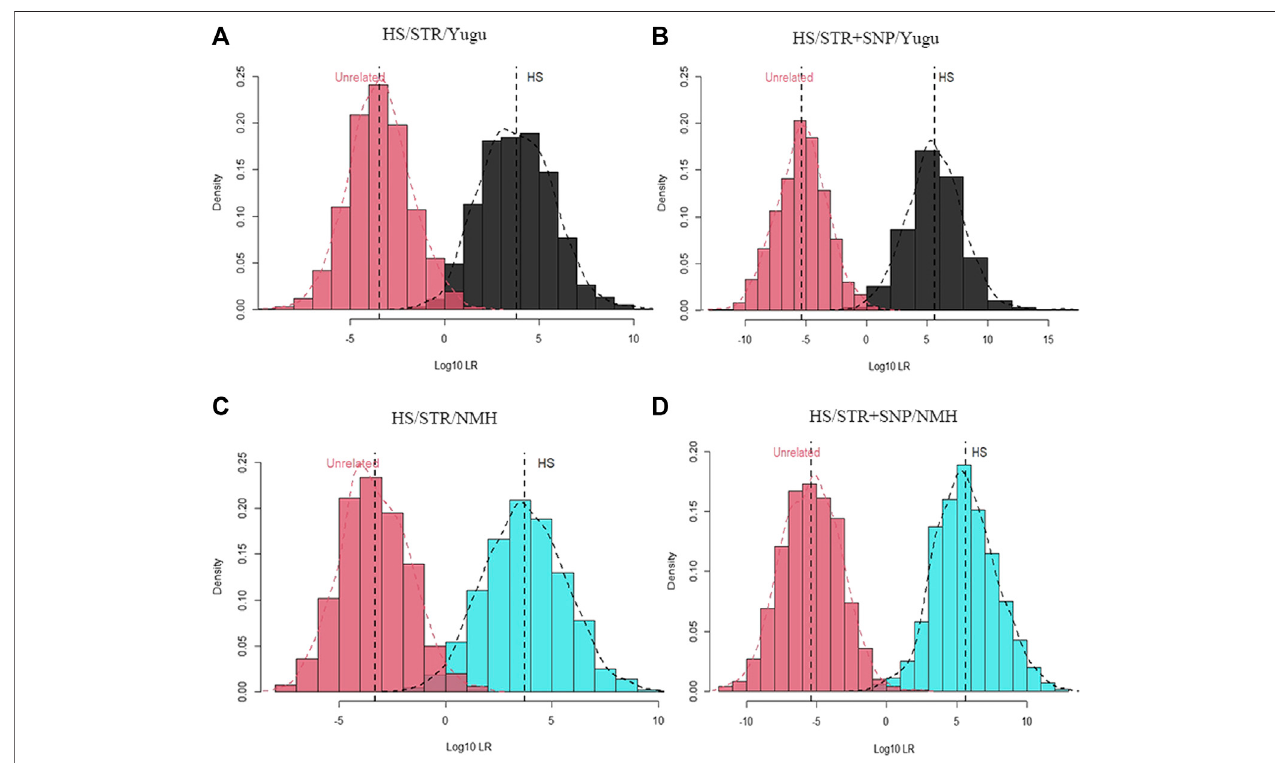
FIGURE 5 | Log 10 LR distribution plots obtained from 1000 simulations of relationship tests between half siblings and unrelated individuals. (A) Log 10 LR distributions when only using 54 A-STR loci to distinguish half siblings from unrelated individuals in the Yugu ethnic group; (B) Log 10 LR distributions when using 54 A-STR loci and 133 iiSNPs to distinguish halfsiblings from unrelated individuals in the Yugu ethnic group; (C) Log 10 LR distributions when only using 54A-STR loci to distinguish half siblings from unrelated individuals in the NMH population; (D) Log 10 LR distributions when using 54 A-STR loci and 133 iiSNPs to distinguish half siblings from unrelated individuals in the NMH